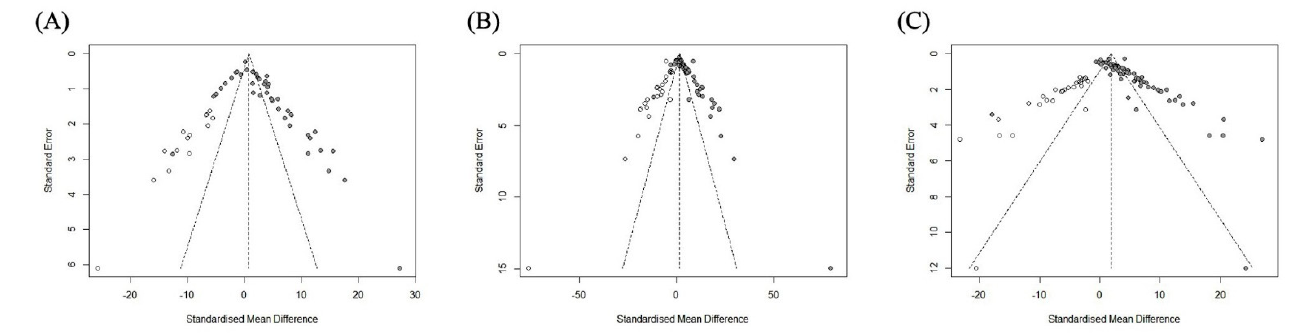
Table 5. Egger’s linear regression test for publication bias analysis.